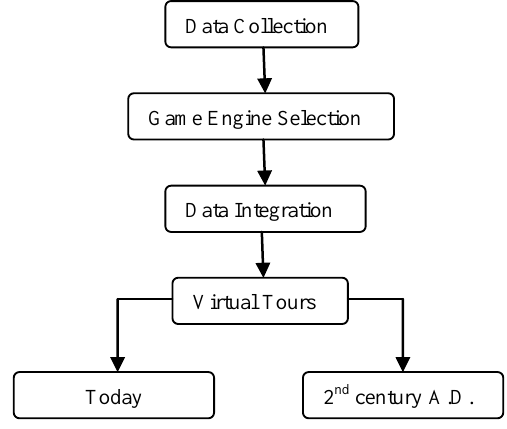
Figure 1: Workflow of the methodology